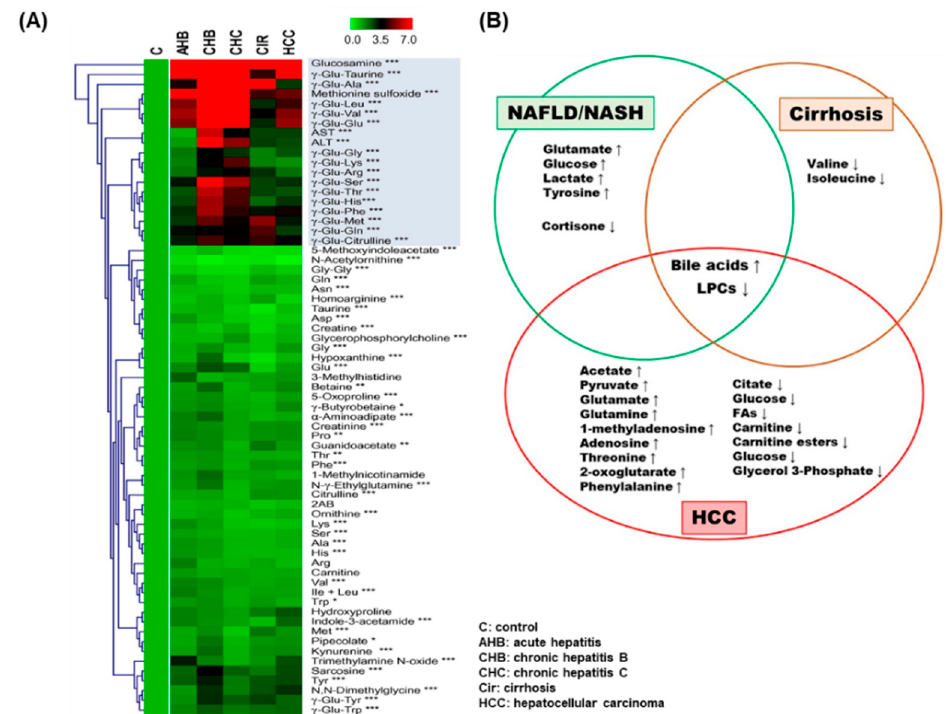
Figure 6. Significant metabolome in liver diseases. ( A ) 67 metabolites from various types of liver diseases. All rows and columns display the targeted metabolites regulations and liver diseases, respectively. * p < 0.05, ** p < 0.01, *** p < 0.0001 was calculated. Adapted from references [72], Copyright 2011, European Association for the Study of the Liver. Published by Elsevier Ireland Ltd. ( B ) The regulation of up- and downregulated metabolites in HCC, cirrhosis, and non-alcoholic fatty liver disease (NAFLD)/non-alcoholic steatohepatitis (NASH) shown in Venn diagram. Adapted with permission from [73], Copyright 2013, European Association for the Study of the Liver. Published by Elsevier B.V.